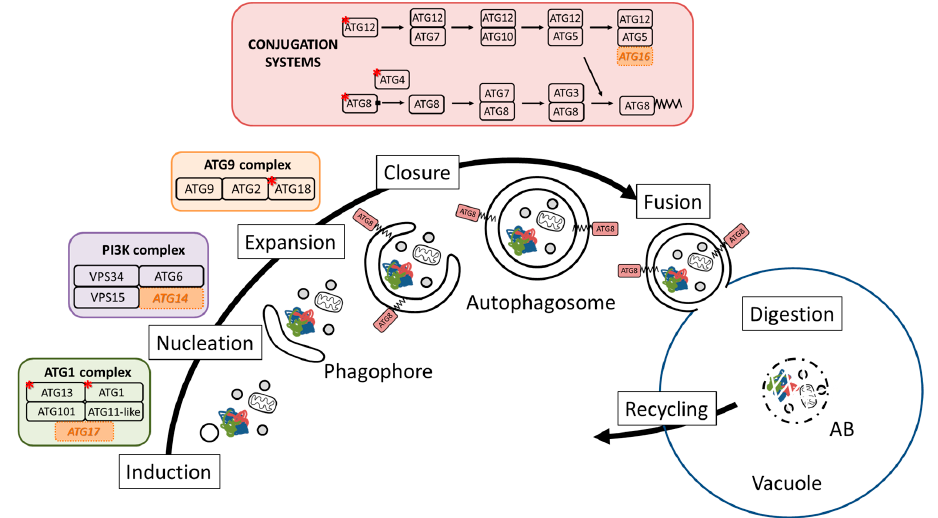
Figure 1. Conservation of the core autophagy machinery in Arabidopsis thaliana , represented by the four main complexes acting along the lifecycle of an autophagosome. (*) indicates the occurrence of several isoforms of the protein in plants. Italics in orange boxes indicate the absence of a functional counterpart in Arabidopsis thaliana.